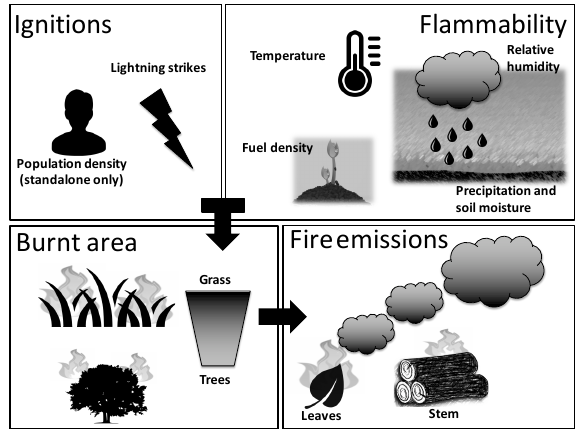
Figure 1. Schematic summarising the INteractive Fire and Emis- sion algoRithm for Natural envirOnments (INFERNO) and its key components and behaviour. Ignitions can be accounted for in a va- riety of ways (see Sect. 2.1.1), meteorology influences flammability (see Sect. 2.1.2), while plant coverage influences burnt area (see Sect. 2.1.3), finally emissions are calculated according to leaf and stem carbon for each PFT (see Sect.